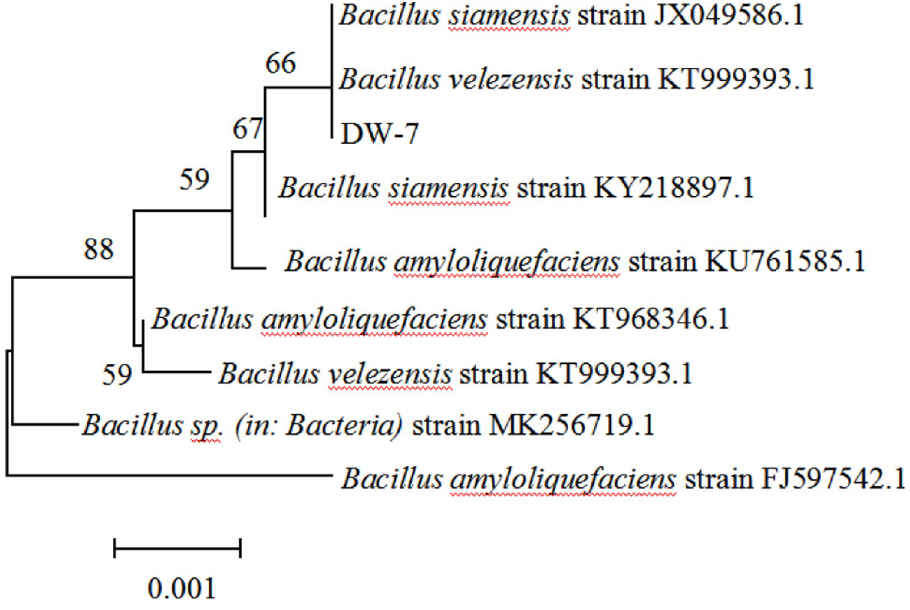
Fig 4. Phylogenetic tree of the DW-7 bacteria.